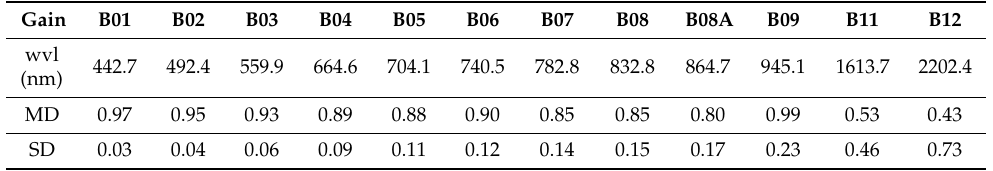
Table 4. Belharmony gains as median (MD) and the standard deviation (SD) for MSI/S2A bands. The wavelength of each band (wvl) is calculated by Equation (2).